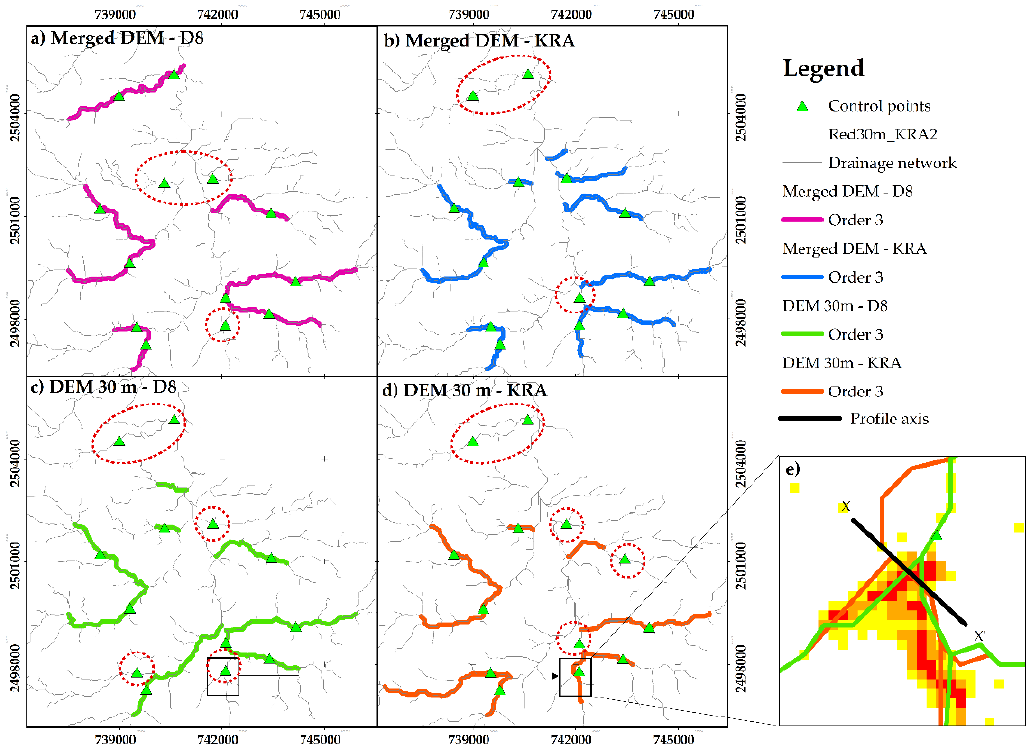
Figure 9. Drainage networks, control points, channels of stream order 3, and X-X’ axis over filled cells.